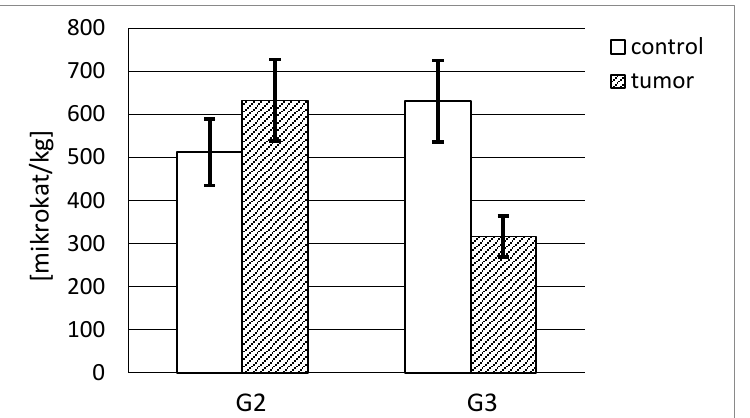
Figure 7. MMP-3 specific activity in human kidney tumor (G2 grade and G3 grade) and respective control tissue. p < 0.001—cancer vs. respective control kidney; p < 0.001 G3 grade vs. G2 grade human kidney cancer.